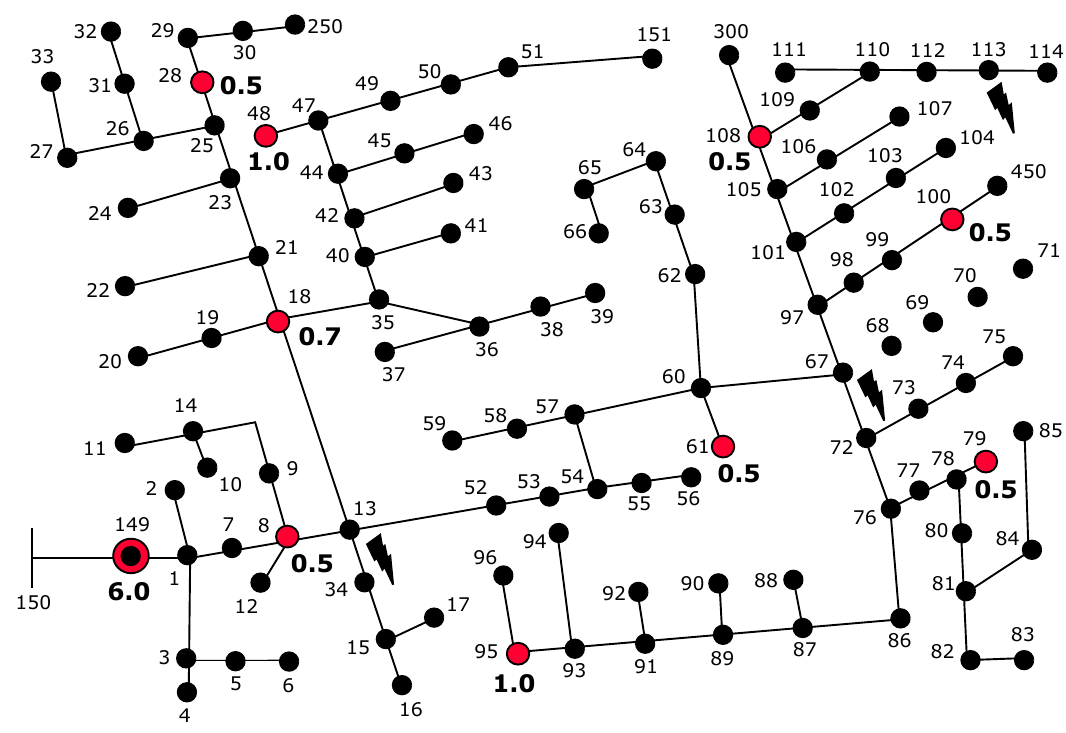
Figure 5. The IEEE 123-Node System